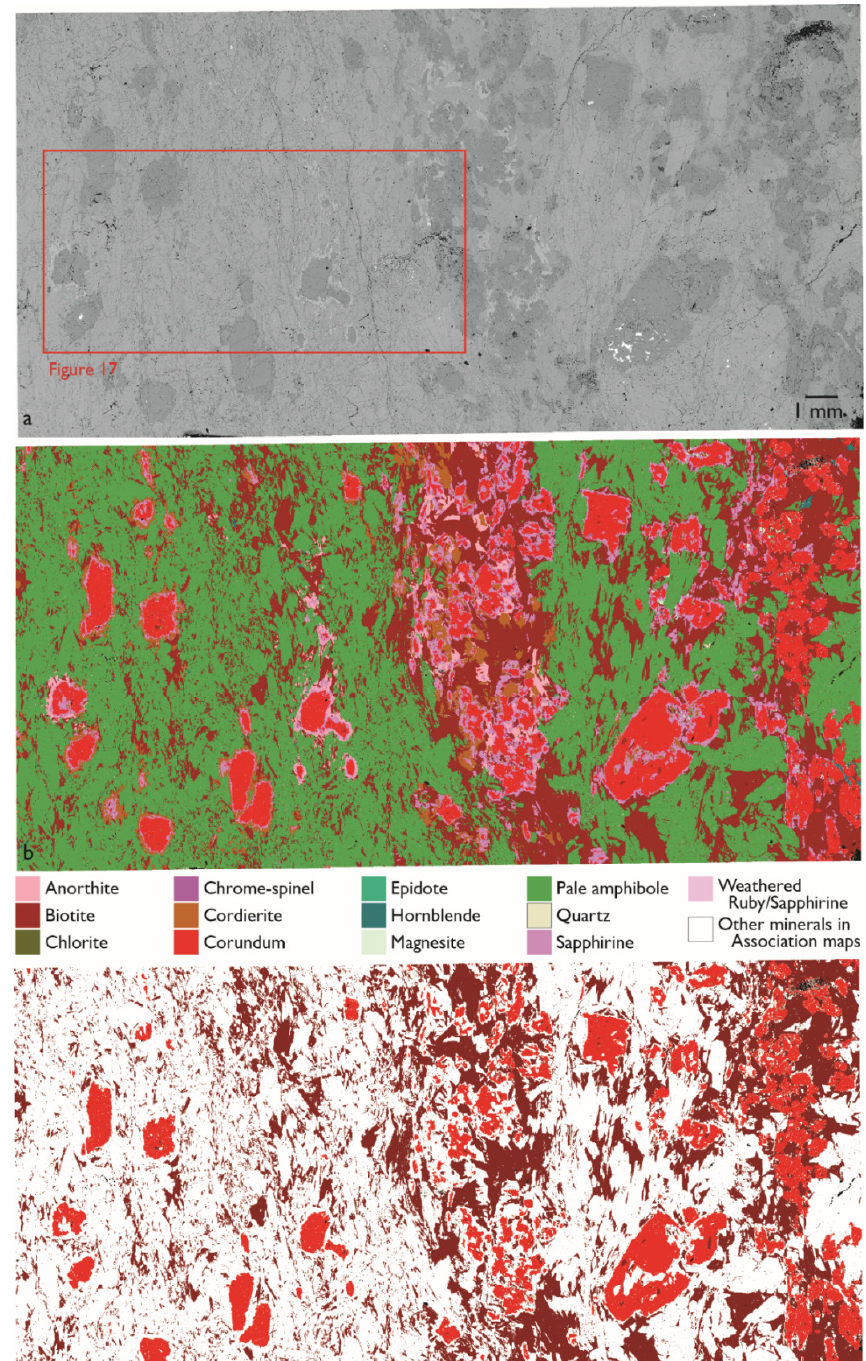
Figure 9. Corundum (Ruby-)bearing rock showing the mineral assembly after the formation of corundum, sapphirine, cordierite, anorthite, pale amphibole and biotite (peak metamorphic reaction products) and the retrograde reaction products magnesite, chlorite, and quartz. ( a ) BSE image of a selected part of the sample. ( b ) Mineral map of nearly the entire thin section of the sample (1.63 million pixels). ( c ) Mineral association map of biotite and ruby. All other minerals are displayed in white.